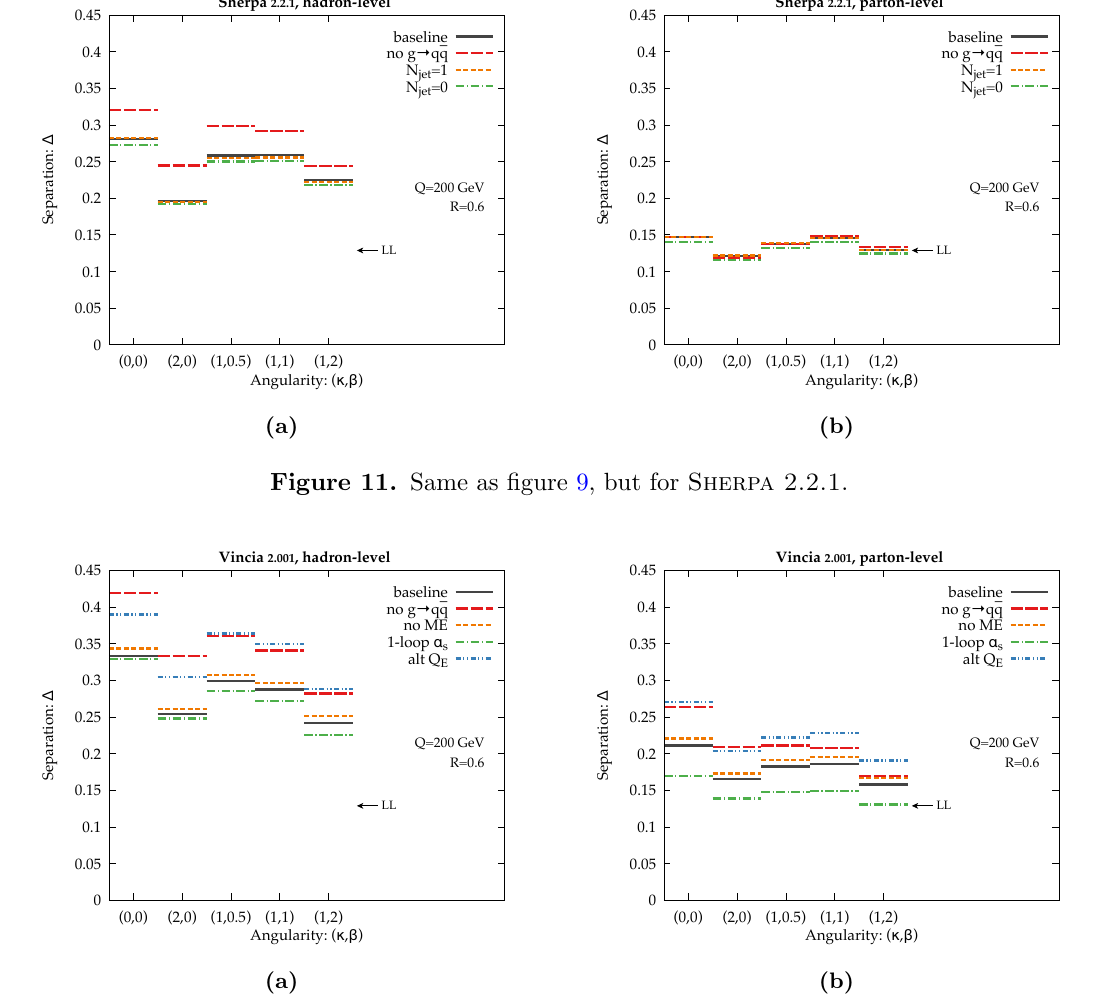
Figure 12. Same as (cid:12)gure 9, but for Vincia 2.001